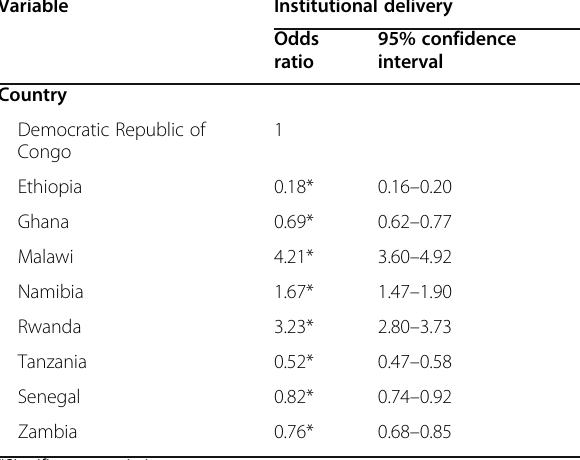
Table 3 Multivariable logistic regression analysis of factors associated with institutional delivery in Sub-Saharan